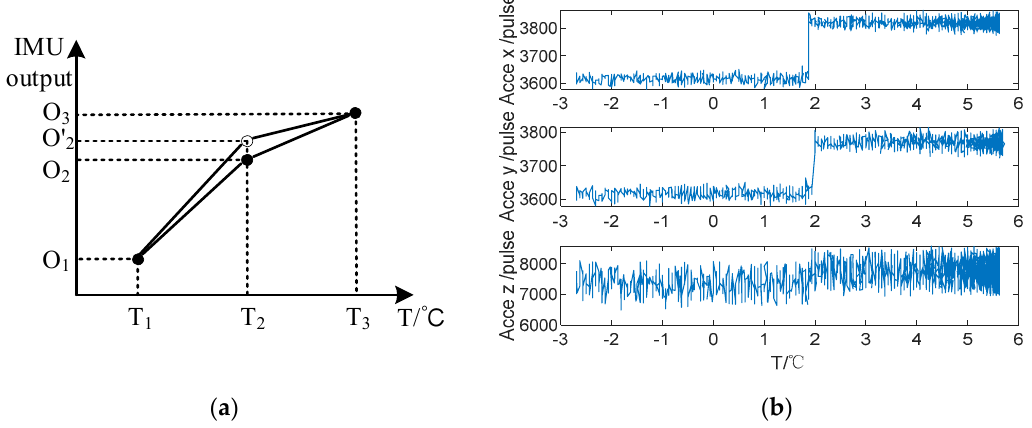
Figure 1. The sectional compensation error analysis. ( a ) The schematic of sectional compensation. ( b ) The accelerometers output at segment point.